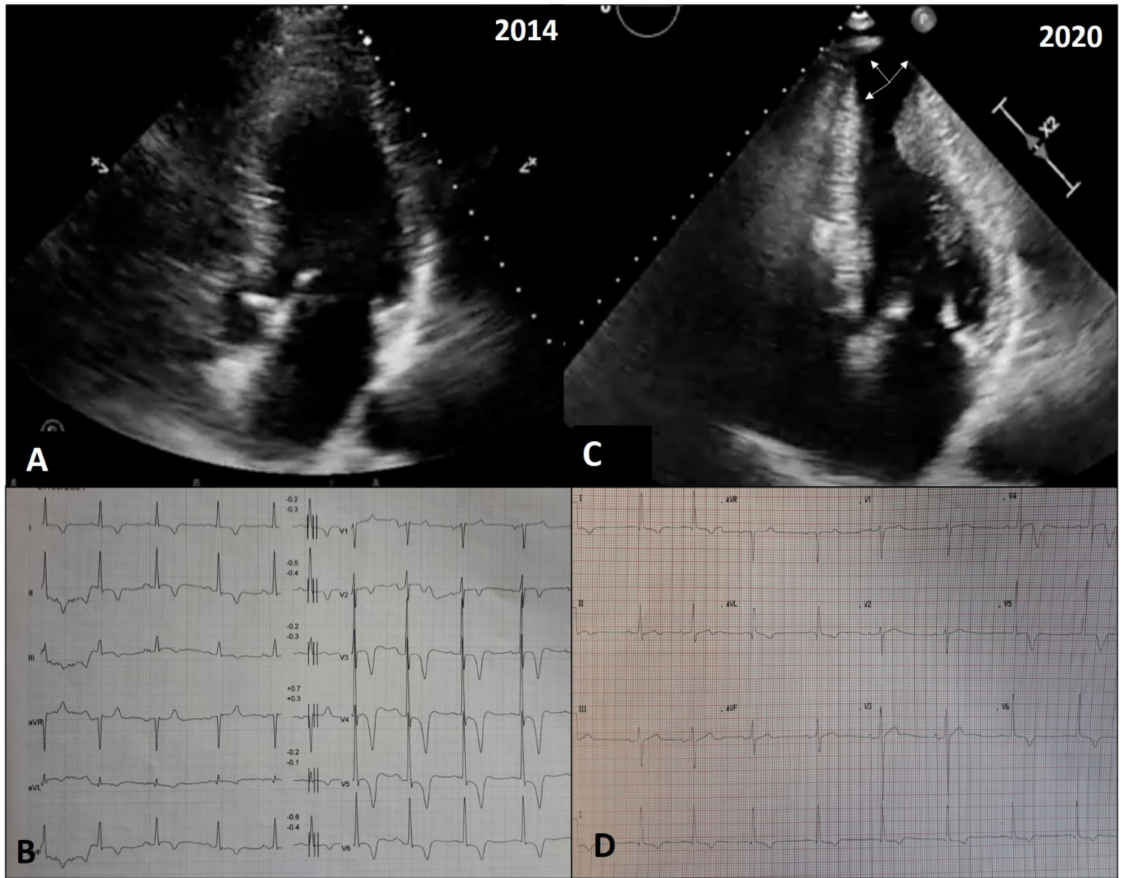
Figure 6. Echocardiographic and electrocardiographic findings in a patient with adverse LV remodeling, characterized by LV wall thinning and development of apical aneurysm. A 66-year-old male with familial HCM was diagnosed and evaluated at our outpatient clinic for the first time in 2014. Apical hypertrophy was evident in the echocardiogram ( A ), with signs of LV hypertrophy and deep inverted T wave in precordial leads in the electrocardiogram ( B ). After 6 years, we observed a significant remodeling of the LV apex with the development of a large aneurysm (arrows, C ). As the apical aneurysm developed, QRS complex amplitude decreased and negative T waves became positive in V1–V3 and biphasic in V4 ( D ). The patient underwent implantation of a cardioverter defibrillator for primary